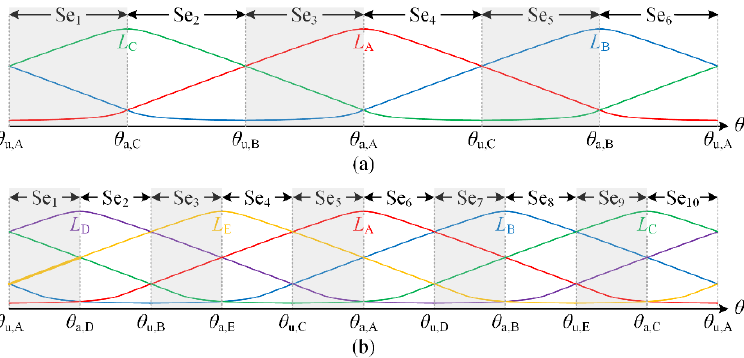
Figure 7. Phase inductance curves. ( a ) Of a three-phase SRM. ( b ) Of a five-phase SRM. It can be observed that an electrical cycle of the three-phase SRM is divided into six sectors by the unaligned and aligned positions of all phases, two inductance curves are rising in the three sectors highlighted by gray rectangles and two inductance curves are falling in the other three sectors. Similarly, an electrical cycle of the five-phase SRM is divided into ten sectors, three inductance curves are ascending in the five sectors marked by gray rectangles and three inductance curves are descending in the other five sectors. In addition, the phases with the same torque direction are consecutively adjacent. Therefore, there are only N p combinations of the ( N p + 1)/2 phases with the same torque direction. For the three-phase SRM, the three combinations are phases A and B, phases B and C, as well as phases C and A. For the five-phase SRM, the five combinations are phases A, B, and C; phases B, C, and D; phases C, D, and E; phases D, E, and A; as well as phases E, A, and B.